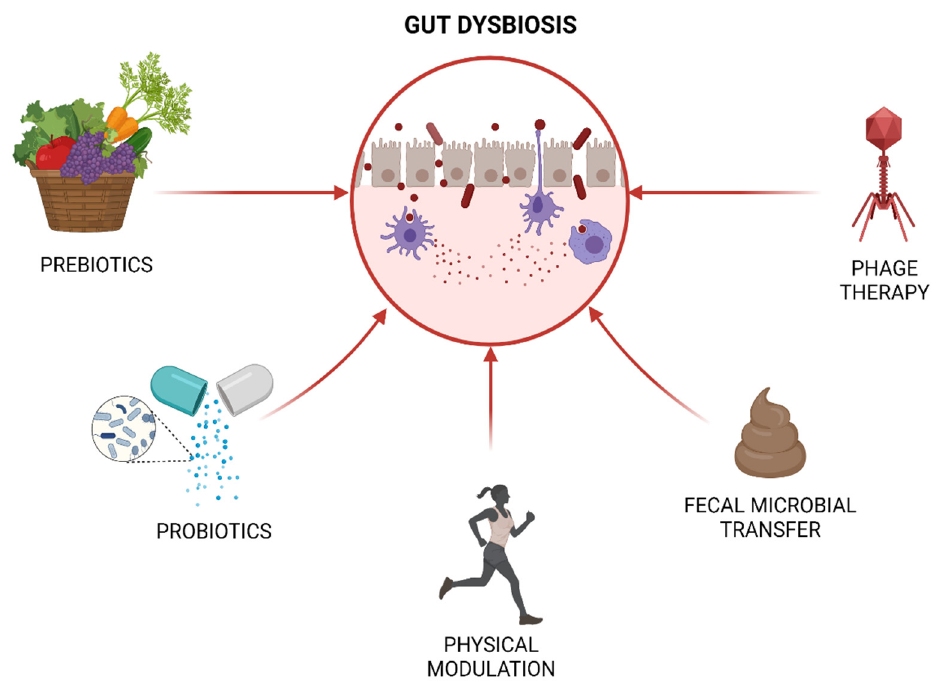
Figure 2. Interventional strategies to counteract dysbiotic gut microbiome.